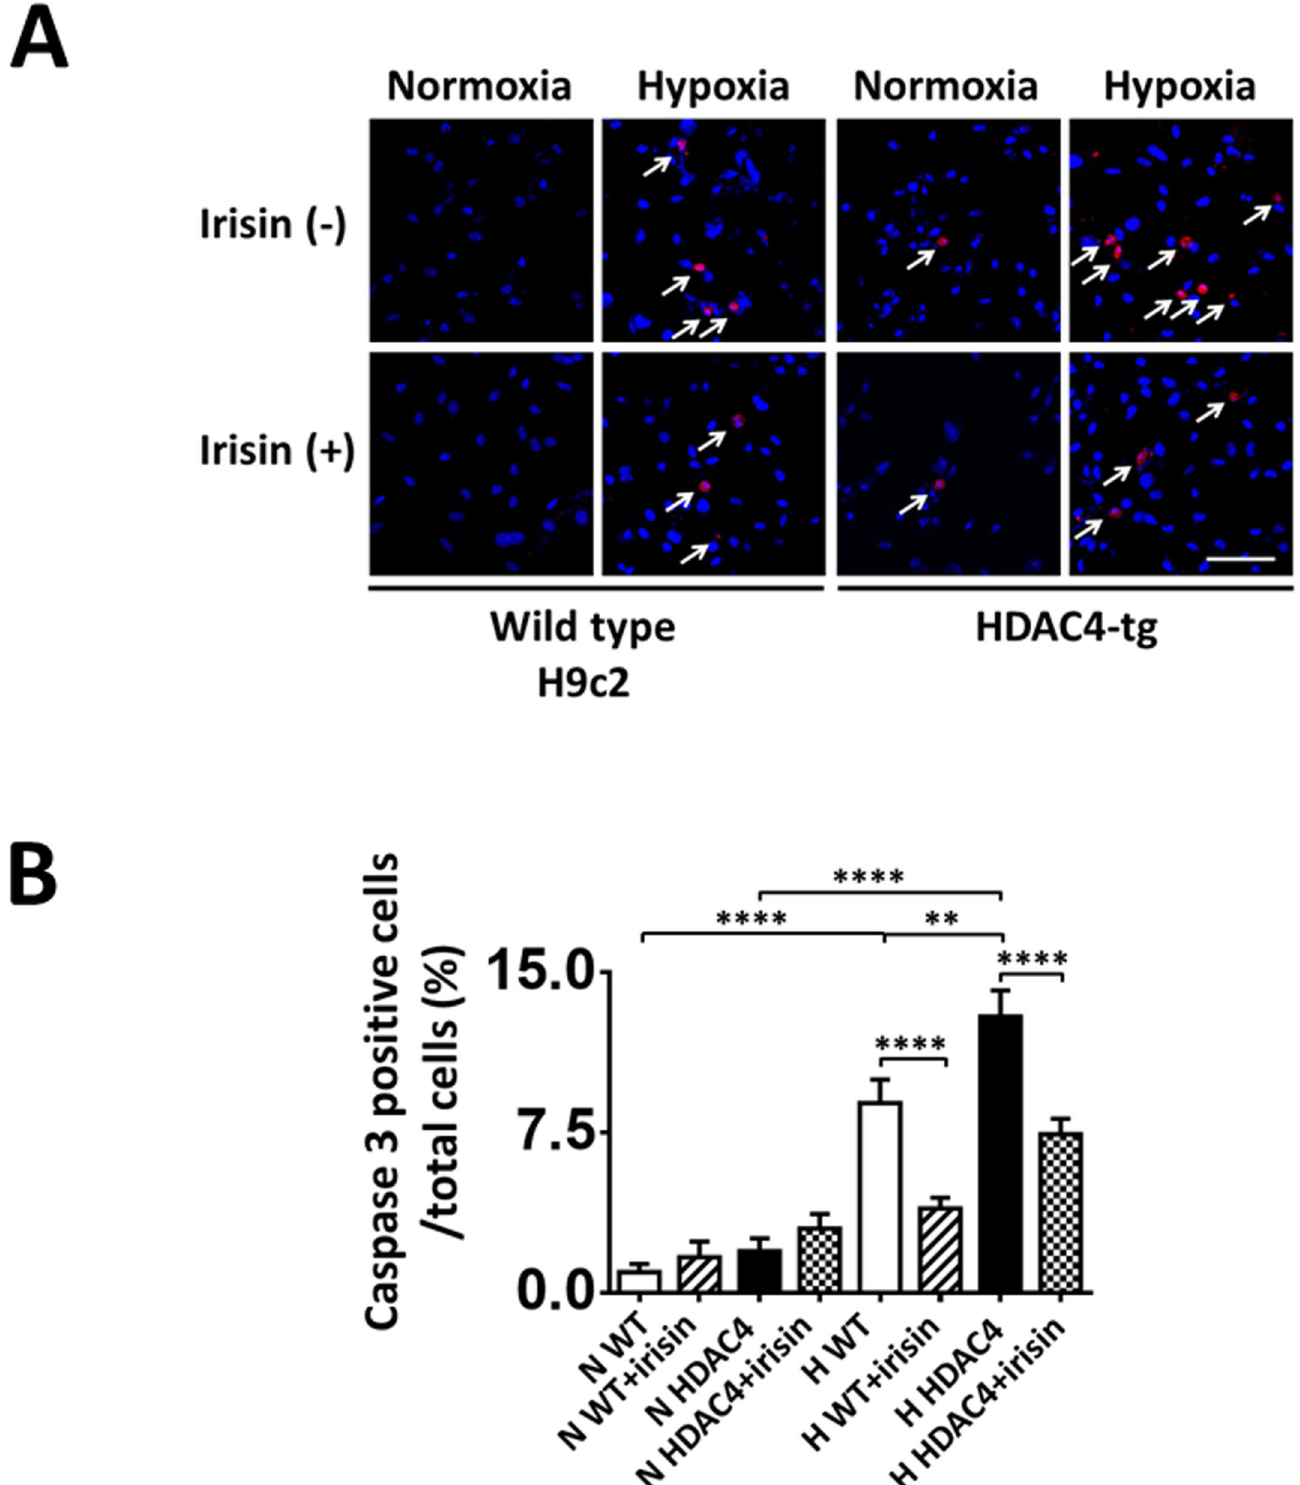
Fig 3. Irisin treatment reduced active caspase-3-positive nuclei in cardiomyoblasts exposed to H/R. (A) Representative images showingthe apoptotic H9c2 cardiomyoblasts: active caspase-3-positive nuclei in red (white arrows); nucleiwere stainedin blue (DAPI). (B) Quantification of active caspase-3-positivenuclei betweengroups. Values represent means ± SE (n = 3/group). *** P < 0.001, **** P < 0.0001.Scale bar: 100 μ m.